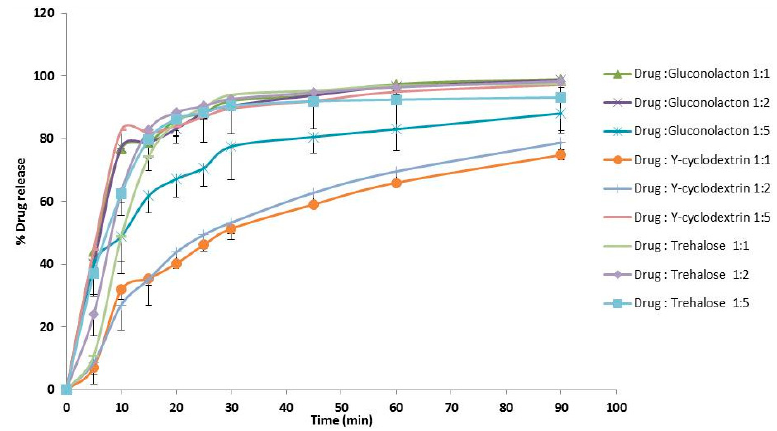
Figure 3. Dissolution studies after Lyophilisation-Freeze drying.